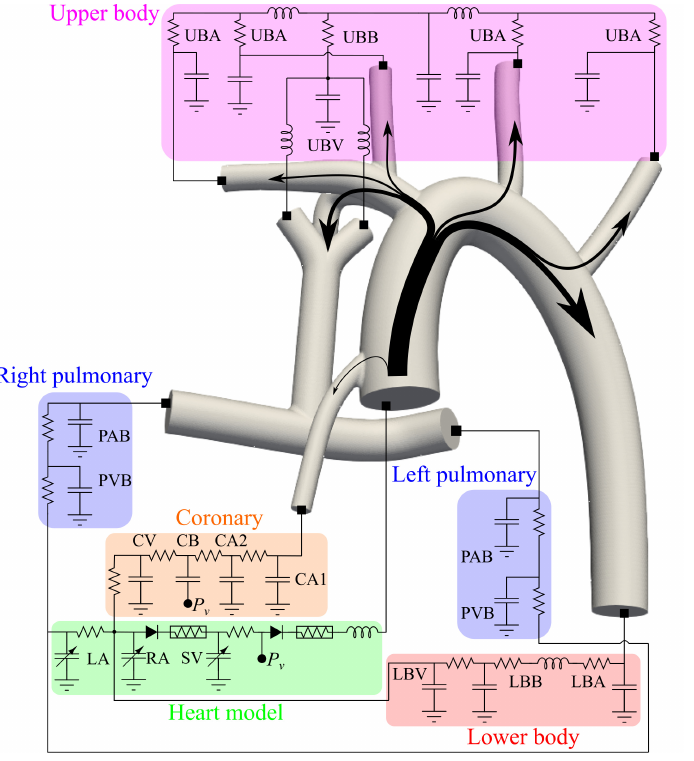
Figure 3. Lumped parameter network coupled with physical domain geometry for the ABG proce- dure. See Appendix A for details.